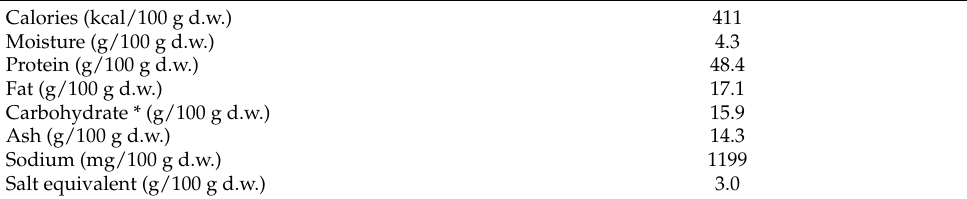
Table 1. Nutritional composition of C. gracilis . Calories (kcal/100 g